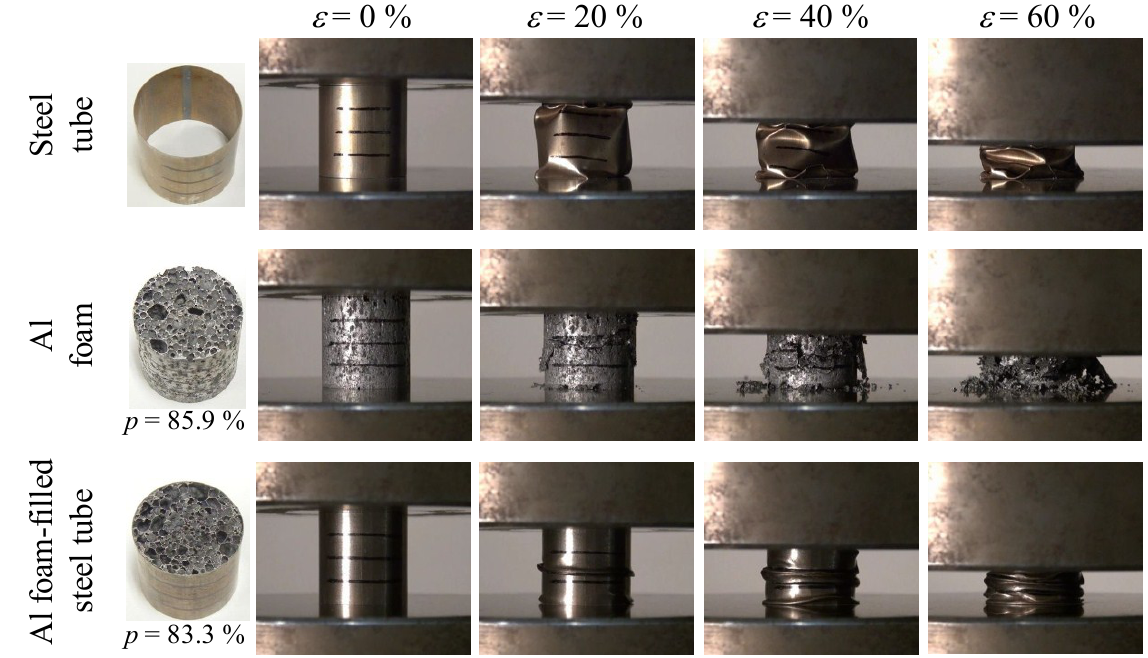
Figure 11. Deformation behaviors of steel tube, Al foam and Al foam-filled steel